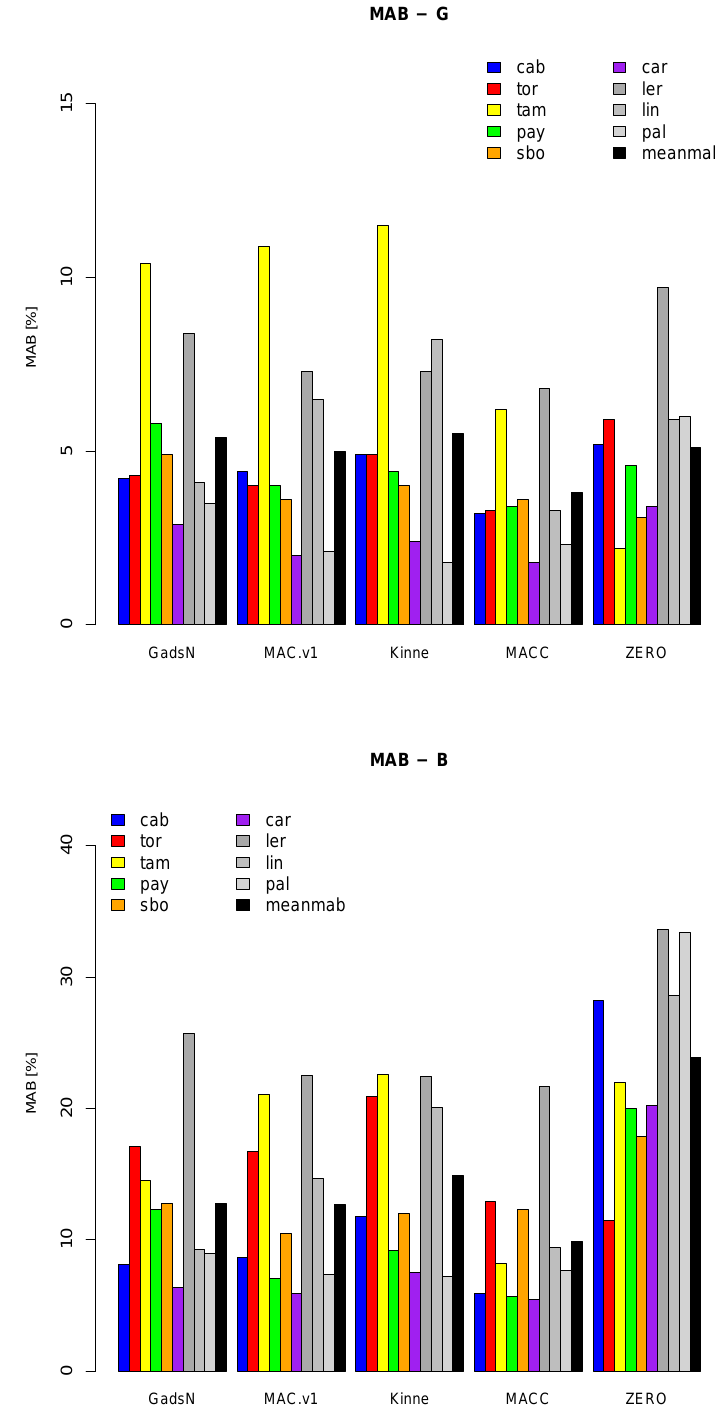
Figure 3. Relative deviation of the Mean Absolute Bias (mean absolute difference) for the global irradiance (MAB-G, top ) and direct irradiance (MAB-B, bottom ) from the mean radiation in percent. The large absolute difference of MAB at the station Tamanraset is much smaller in relative units, cause of the high mean of solar irradiance at this site. In contrast the relative deviation at the site Lerwick is relative high cause of the relative low mean solar